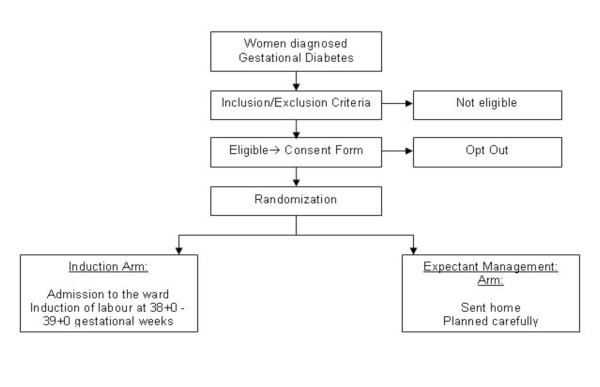
Trial Flow chart.